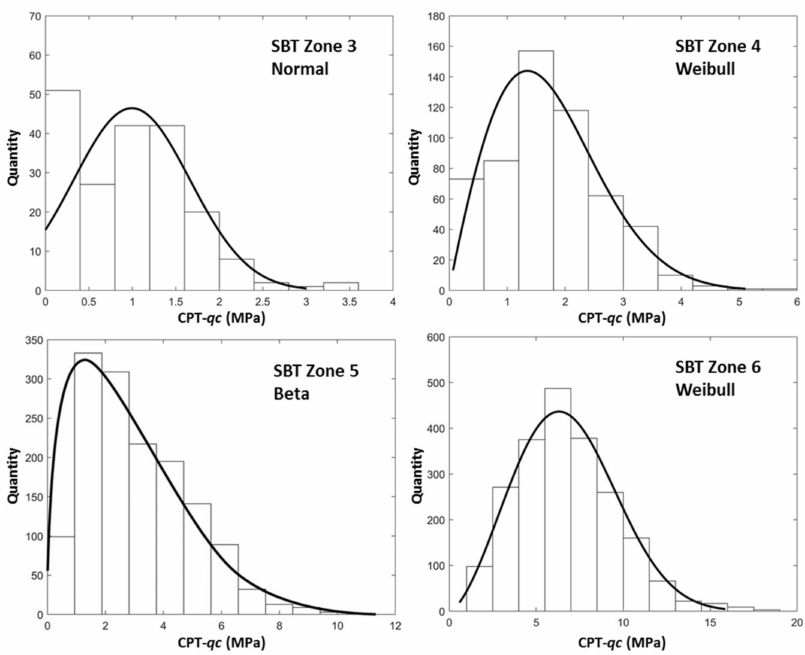
Figure 14. SBT Zone 3 to Zone 6 CPT– q c probability distribution